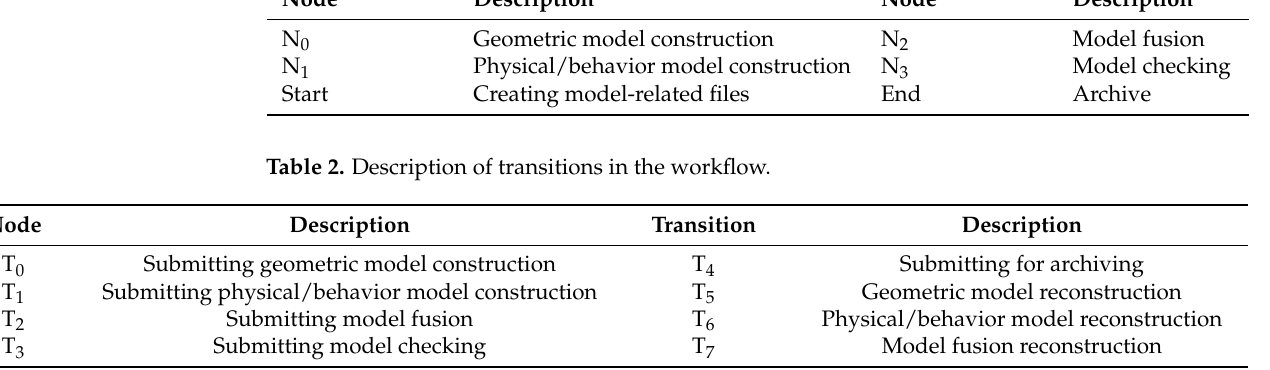
Figure 9. Modeling of the workflow integrated with model evaluation.